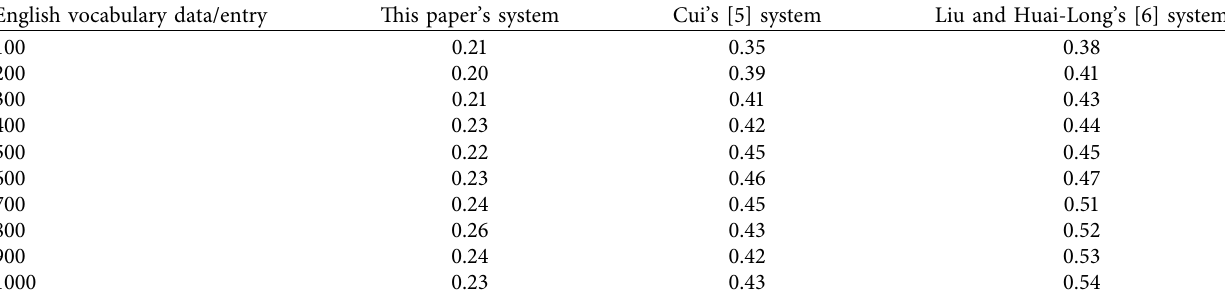
Table 3: Comparison of English vocabulary data transmission speed in different systems